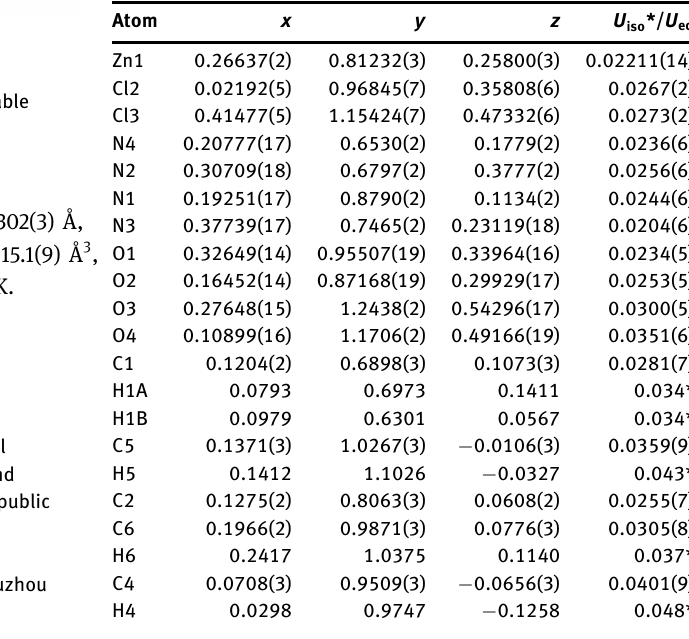
Table 2: Fractional atomic coordinates and isotropic or equivalent isotropic displacement parameters (Å 2